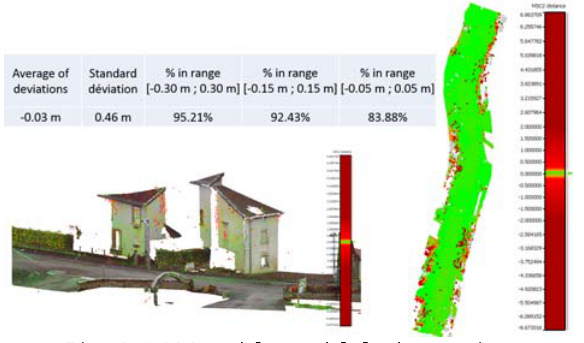
Fig. 12: M3C2 model to model cloud comparison